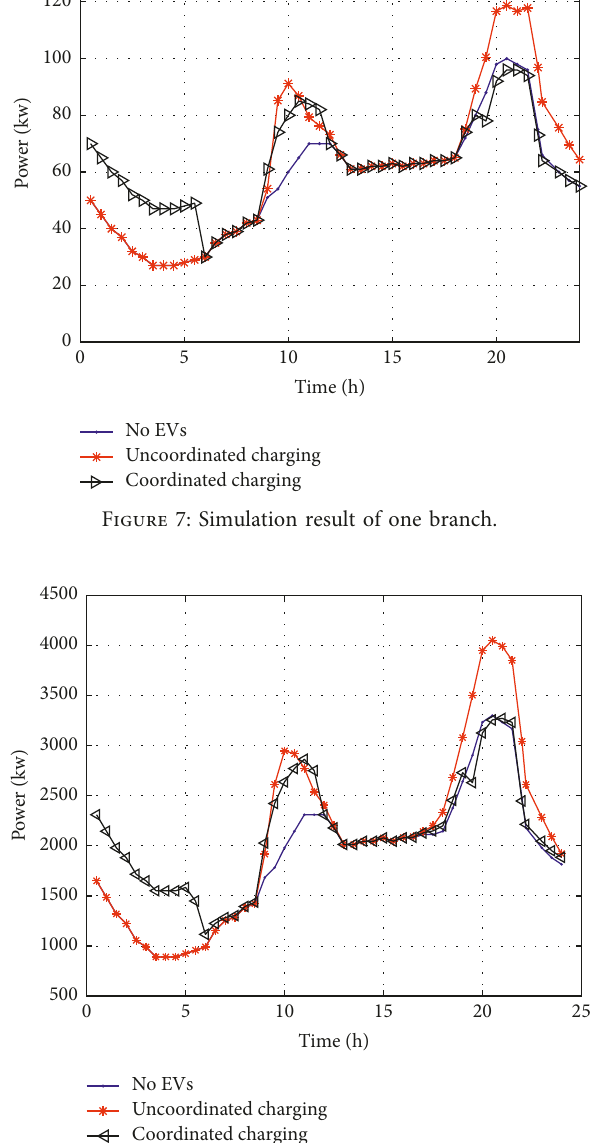
Figure 8: Simulation result of the whole distribution